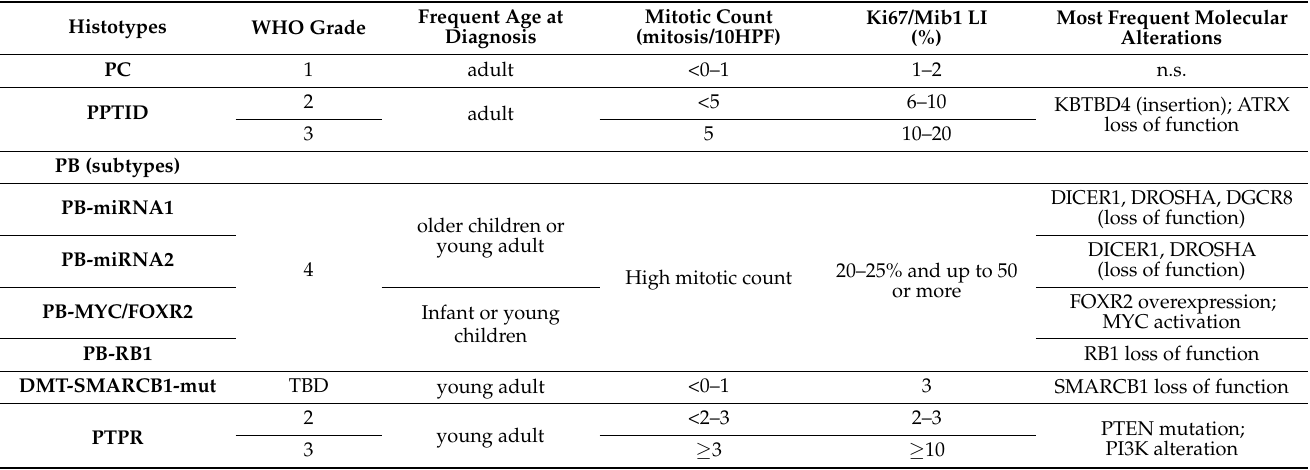
Table 1. Histological and molecular characteristics of pineal region tumors. PC = pineocy- tomas; PPTID = pineal parenchymal tumors of intermediate differentiation; PB = pinealoblastoma; DMT = desmoplastic myxoid tumor; PTPR = papillary tumor of the pineal region, TBD: to be